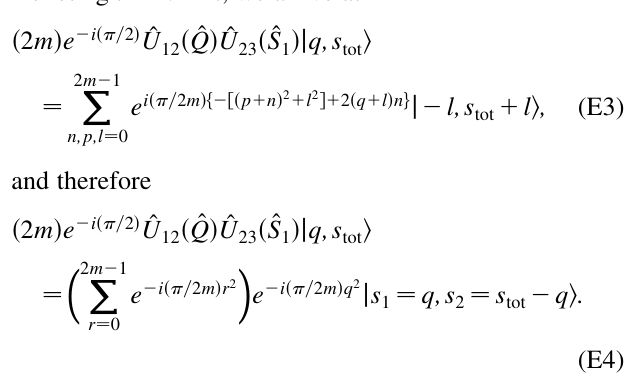
FIG. 7. Properties of particle exchanges. (i) Two consecutive exchanges, first between particles a and b , and then between particles a and c . (ii) Particle a is exchanged with a particle d , which is the particle resulting from fusing b and c . For two- dimensional anyons, a proper definition of the braid matrix between any two particle types establishes an equality between (i) and (ii). For the case a ¼ b ¼ c ¼ X and d ¼ q , we use only the property that the two braids in (i) move the label q one , segment to the left, as shown in (ii). For the case where a ¼ q 1 þ q b ¼ q , c ¼ q , and d ¼ q mod 2 m , we show that the two 2 3 2 3 sides are indeed